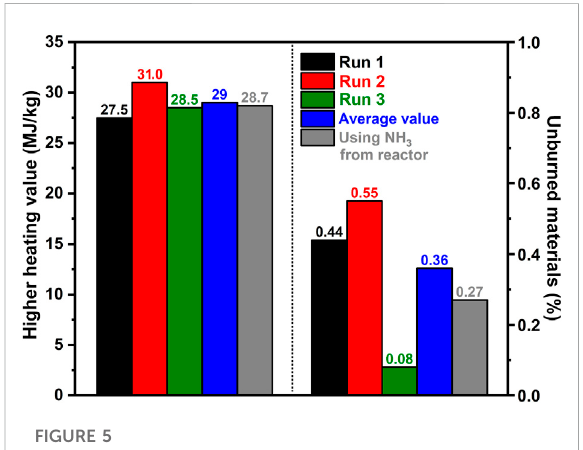
FIGURE 5 Heating value of the organic phase of the separated bio-oil and the unburned residue post combustion.